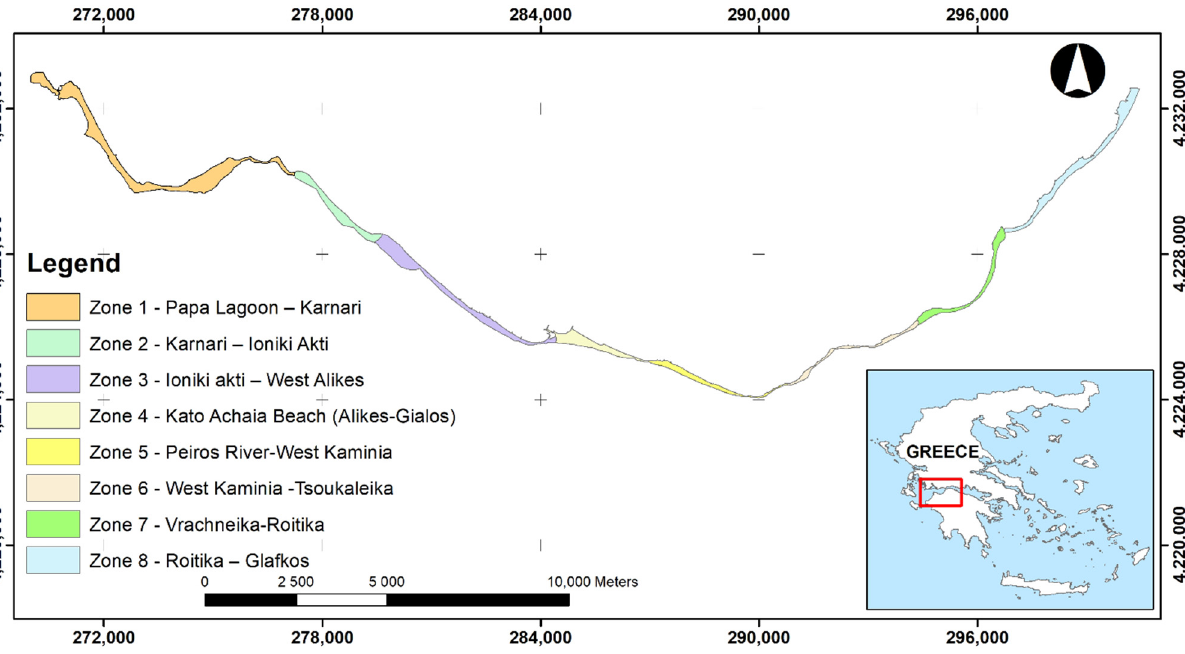
Figure 2. Map of the study area separated in eight zones (use of the Hellenic Geodetic Reference System, 1987).